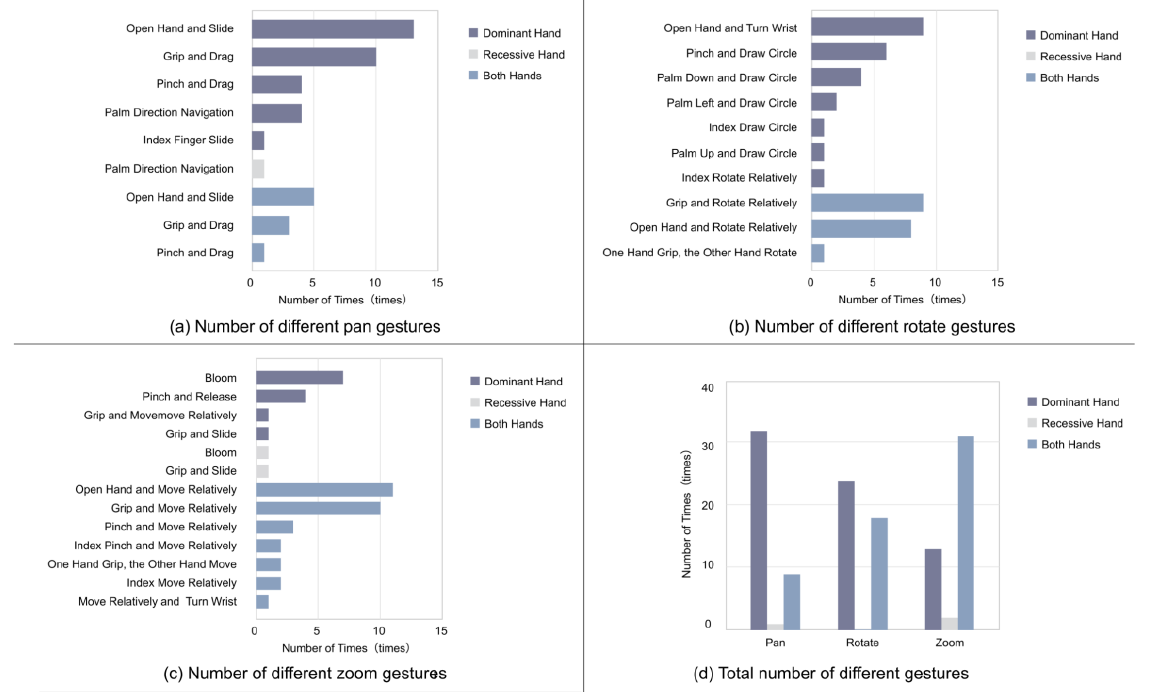
Figure 2. Results of the heuristic gesture collection experiment.